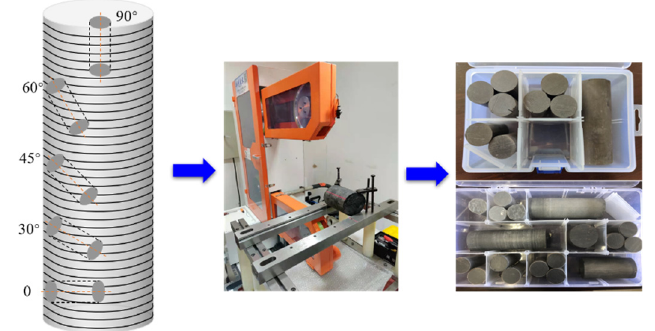
Figure 1. Preparation of standard rock samples by NC wire cutting.